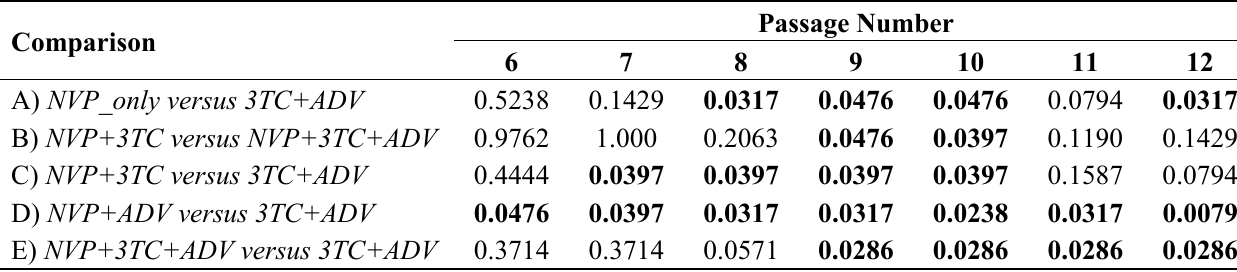
Table 1. Comparison across passage numbers and drug combinations; testing the null hypotheses that numbers of mutations result in identical sampling distributions no matter which of two combinations of drugs was administered. P-values (<0.05 in bold ) for comparisons (A) to (E); passage numbers